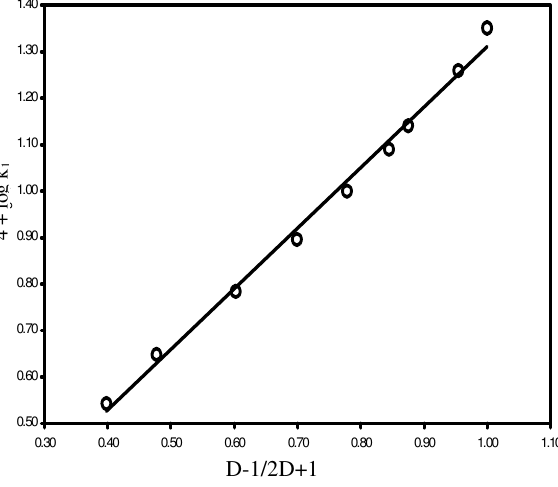
Figure 4. Variation of rate with solvent concentration Table 5. Thermadynamic parameters for lactic acid and mandelic acid